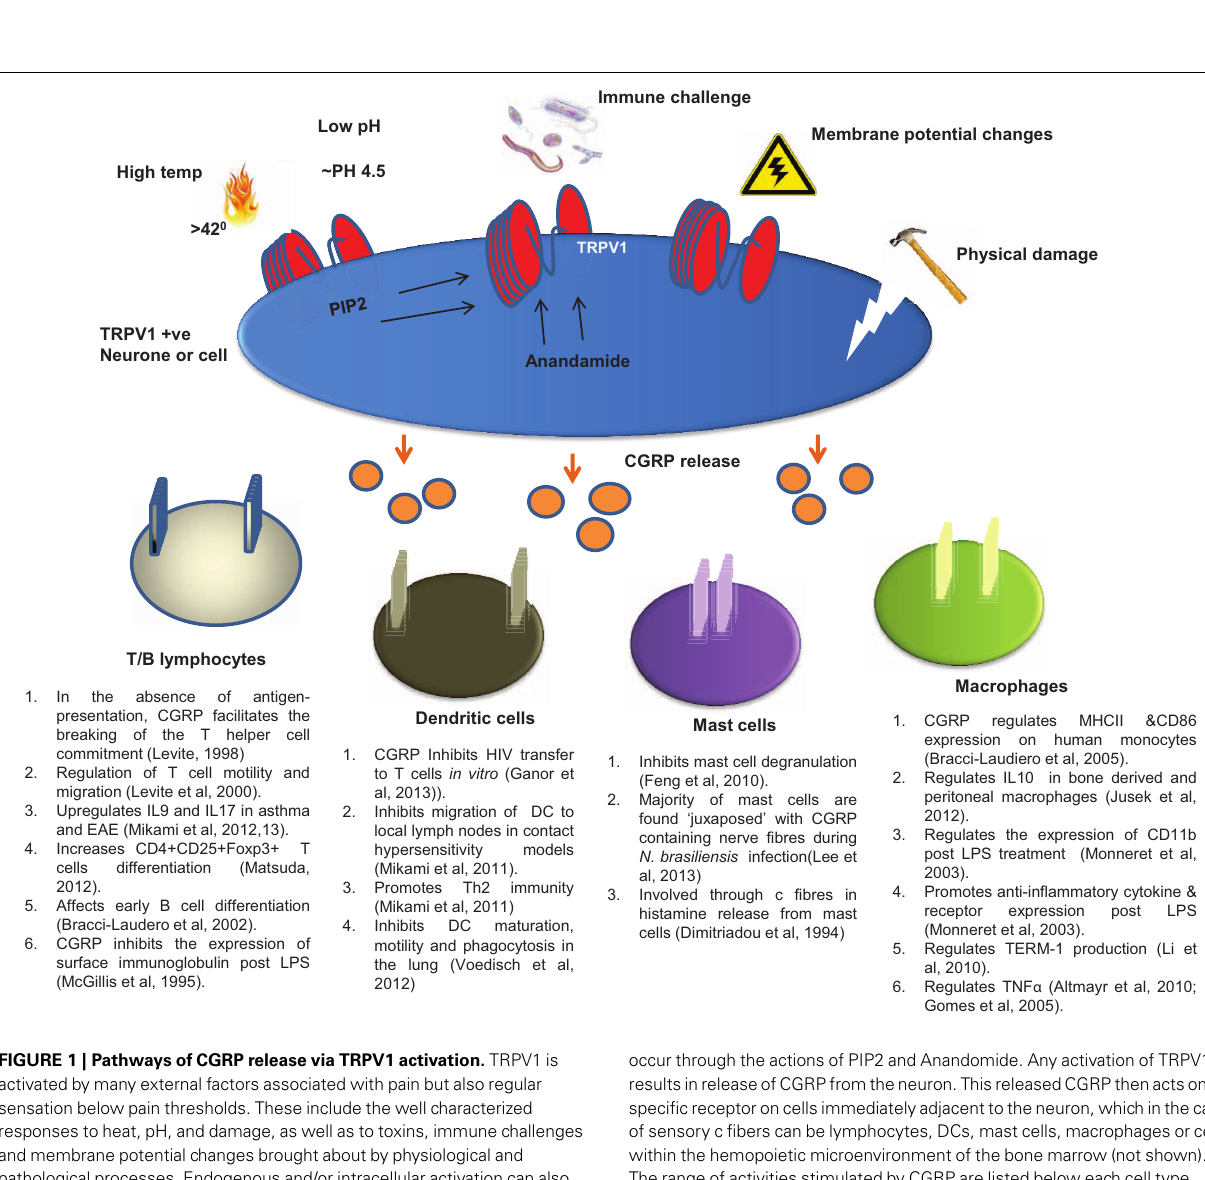
FIGURE 1 | Pathways of CGRP release via TRPV1 activation. TRPV1 is activated by many external factors associated with pain but also regular sensation below pain thresholds. These include the well characterized responses to heat, pH, and damage, as well as to toxins, immune challenges and membrane potential changes brought about by physiological and pathological processes. Endogenous and/or intracellular activation can also